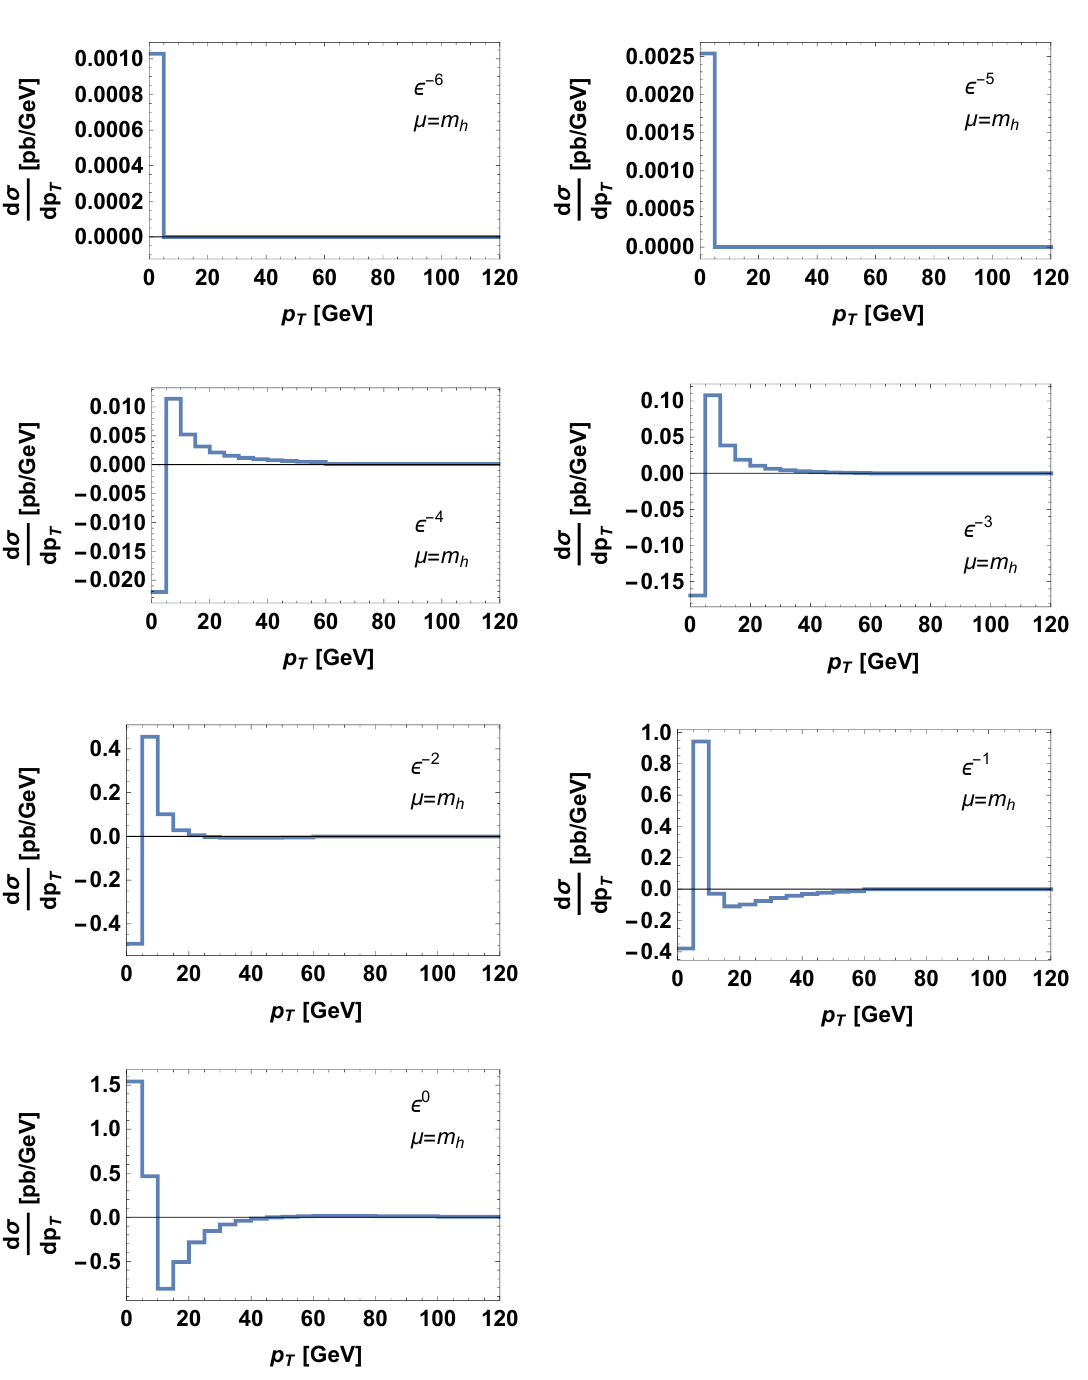
Figure 1 . Distributions for the Higgs transverse momentum p T for each pole in the dimensional regulator " . The deepest poles " (cid:0) 6 and " (cid:0) 5 are proportional to the born cross-section, for which the expected distribution is obtained. The bands in the bins correspond to numerical